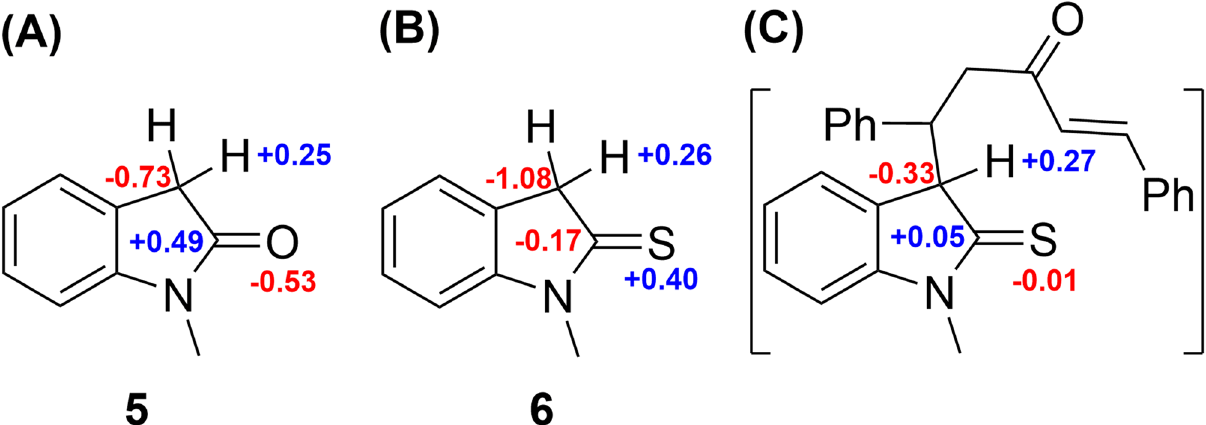
Figure 5. Mulliken charge distribution on ( A ) N-methyl oxindole 5 , ( B ) N-methyl thiooxindole 6 and ( C ) the intermediate after the first Michael addition on N-methyl thiooxindole 6 . Calculations were performed using B3LYP/6-31G(d) in the gas